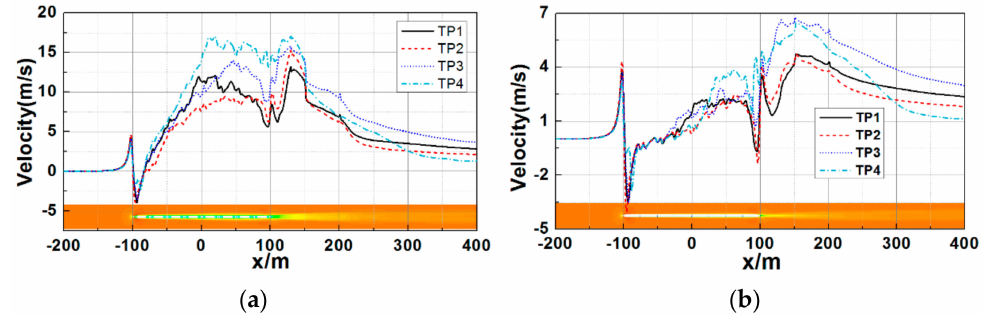
Figure 15. Curves of time-averaged velocity of the train-induced wind at standard positions: ( a ) z = 0.2 m; ( b ) z = 1.44 m.